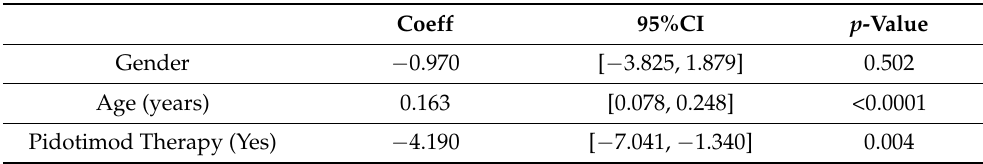
Table 5. Multiple linear model for the illness